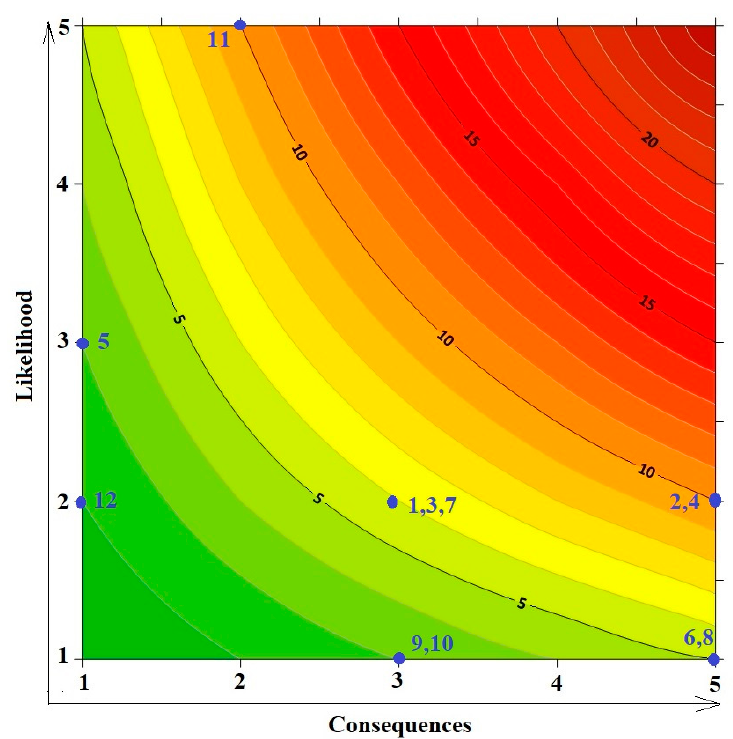
Figure 2. Risk heat map for environmental impacts of CBM exploration (drilling rig locations, drilling operations). Energies 2020 , 13 , x FOR PEER REVIEW